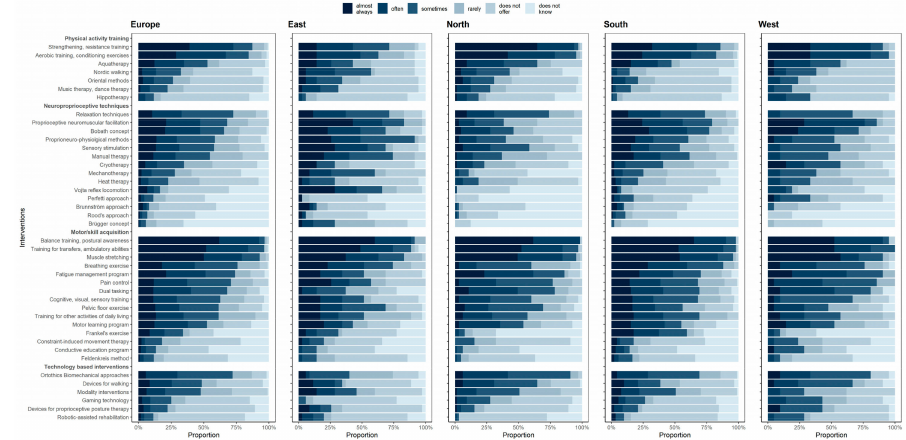
Figure 1. Knowledge and use of interventions by physiotherapists in Europe and four European regions.